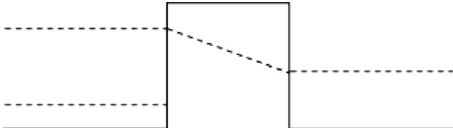
FIG. 9. A reproduction of a graph drawn by a student to repre- sent the potential (cid:1) solid line (cid:2) and total (cid:1) dotted lines (cid:2) energies of a particle tunneling through a barrier. This student said the particle was losing energy because only a part of it